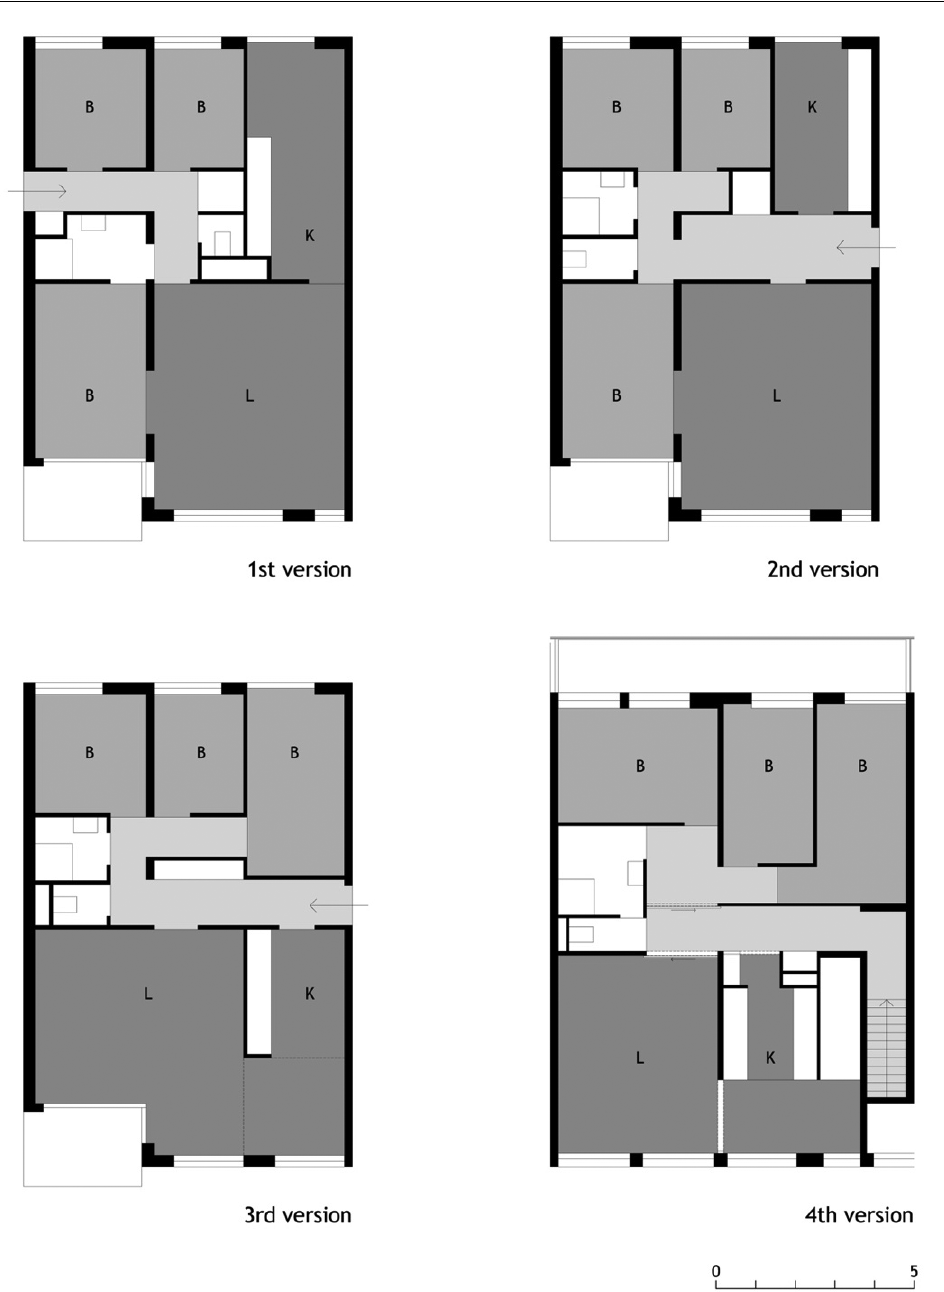
Figure 8. Evolution of the layout of the floorplan for the apartments in the Punt en Komma blocks. Author’s drawings. character as in the mid-1980s, visiting the apartments, one can discover a landscape of multiplicities created by the dweller’s customisation of their living environment (Figure